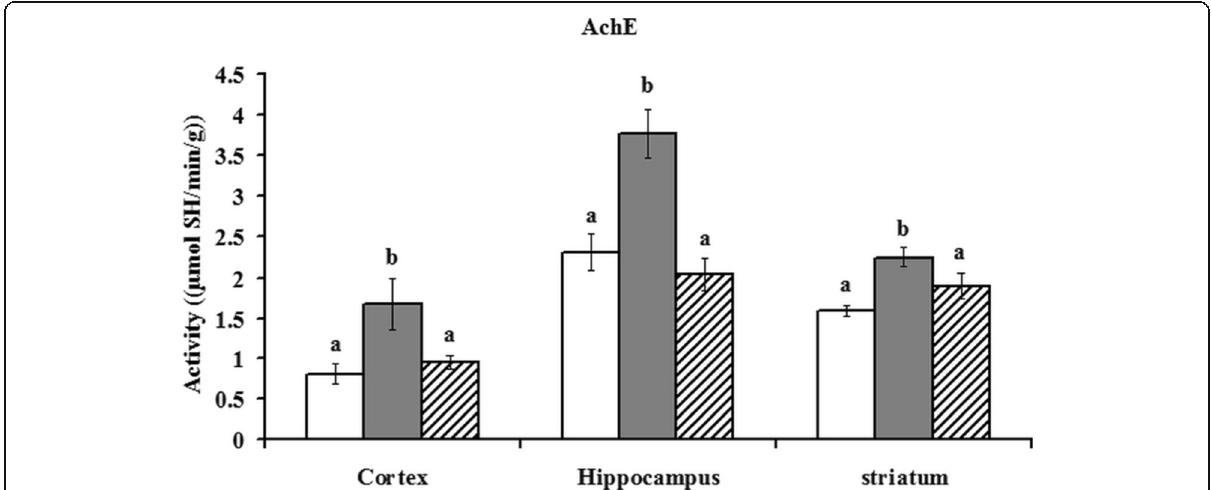
Fig. 3 The Effect of daily protection with frankincense oil (1000 mg/kg/day for 5 days) on the activity of acetylcholinesterase (AchE) in the cortex, hippocampus and striatum in rat model of status epilepticus (SE). Control Rat model of SE.